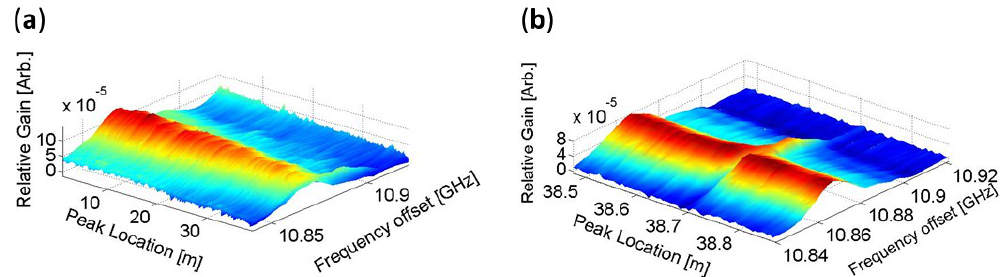
Figure 2. Phase-coded Brillouin optical correlation-domain analysis (B-OCDA) measurements [18]. ( a ) Brillouin gain mapping of a 40-m-long fiber with 1-cm resolution, corresponding to 4000 resolved points. A 1-cm-long section of the fiber was locally heated. ( b ) Magnified view of the Brillouin gain map in the vicinity of the heated section. Reproduced with permission from [18], Wiley, 2012.